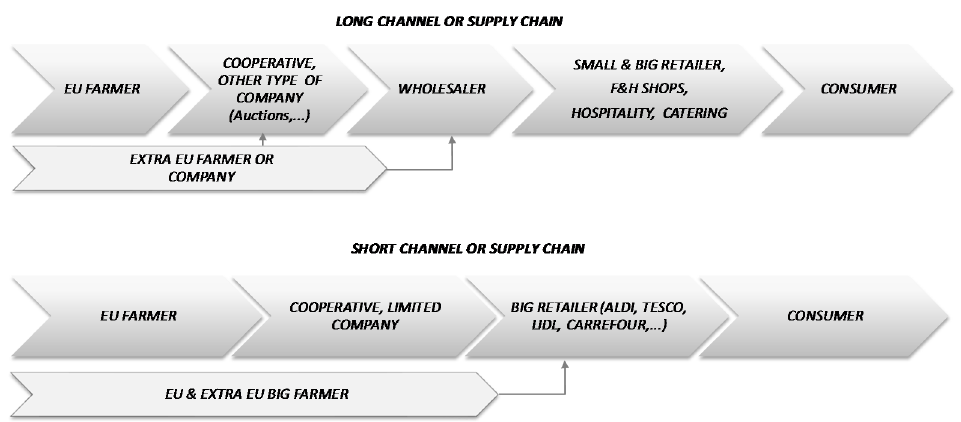
Figure 1. Typology of agri-food supply chains. Source: Own elaboration.